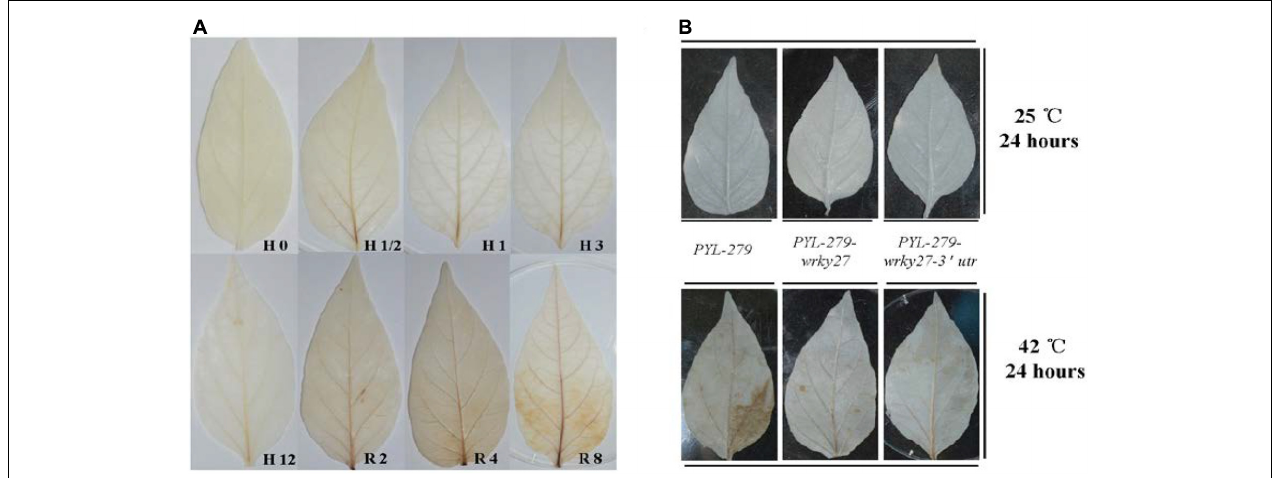
FIGURE 6 | H 2 O 2 accumulated in response to heat treatment. (A) Accumulation of H 2 O 2 was detected in pepper leaves by DAB staining after 0, 0.5, 1, 3, and 12 h at 37 ◦ C and after 2, 4, and 8 h of recovery at 25 ◦ C. (B) The accumulation of H 2 O 2 detected by DAB staining after 0 and 24 h of heat treatment in PYL-279 , PYL-279-wrky27 , and PYL-279-wrky27-3 ’ utr pepper leaves.